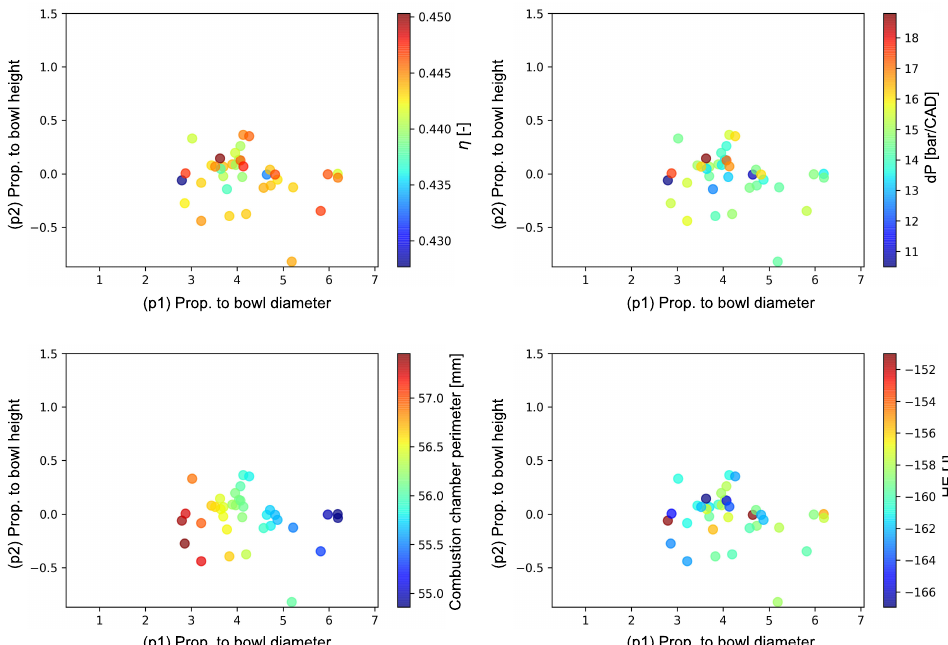
Figure 18. Influence of piston bowl geometry on engine